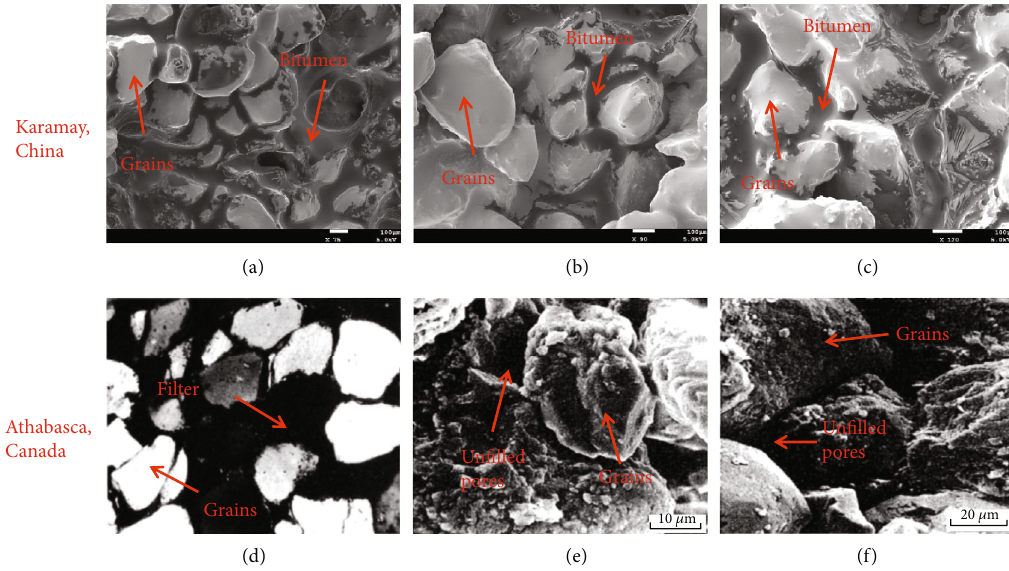
Figure 15: Microstructure contrast of oil sands in Karamay, China and Athabasca, Canada.